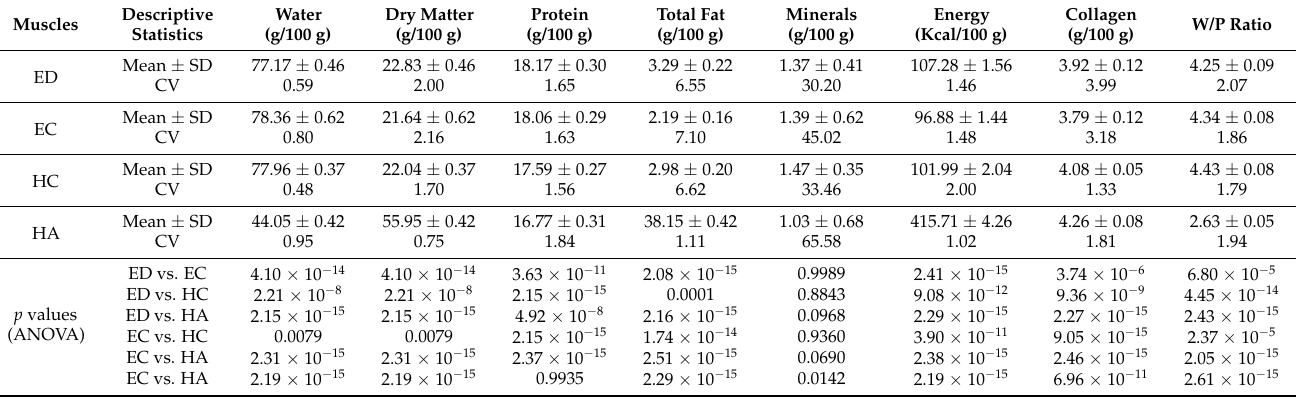
Table 4. Chemical composition and certain nutritional features of Polyodon spathula meat, aged two summers.